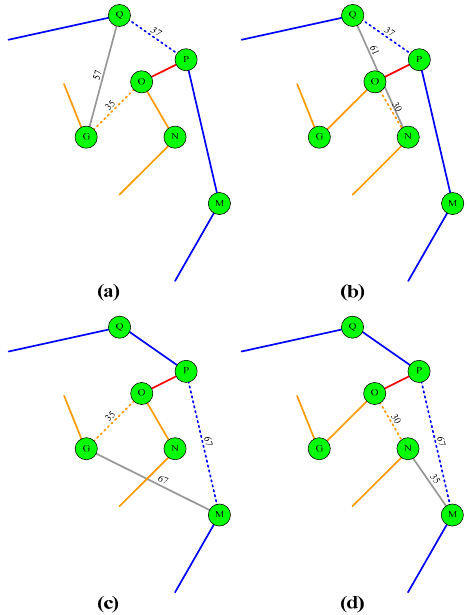
Figure 2. Four cases to merge two adjacent circles. ( a ) the breaking edge of the inner circle is S y S y + 1 and the edge of outer circle is S x S x + 1 . They are QP and OG; ( b ) the breaking edge of the inner circle is S y S y + 1 and the edge of outer circle is S x S x − 1 . They are QP and ON; ( c ) the breaking edge of the inner circle is S y S y − 1 and the edge of outer circle is S x S x + 1 . They are PM and OG; ( d ) the breaking edge of the inner circle is S y S y − 1 and the edge of outer circle is S x S x − 1 . They are PM and